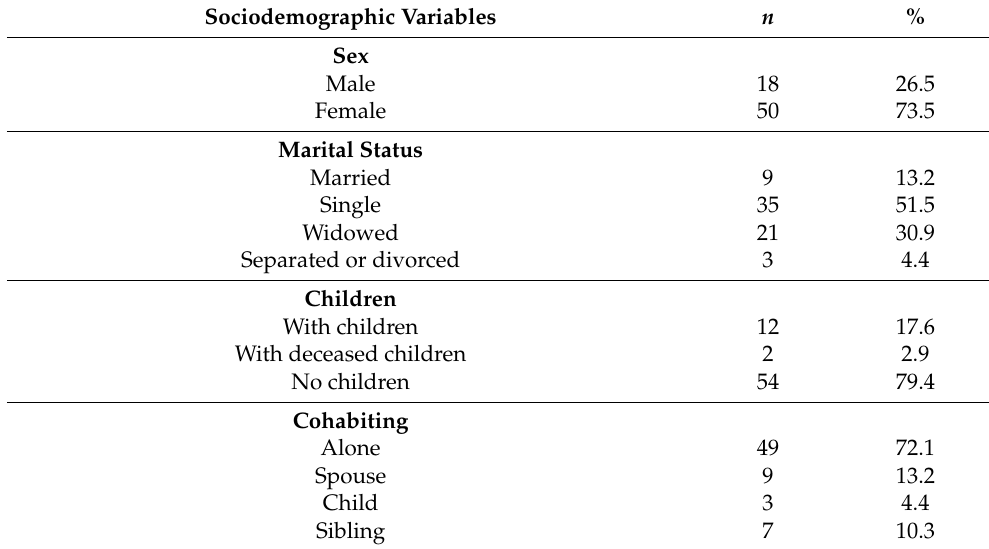
Table 1. Socio-demographic characteristics of the